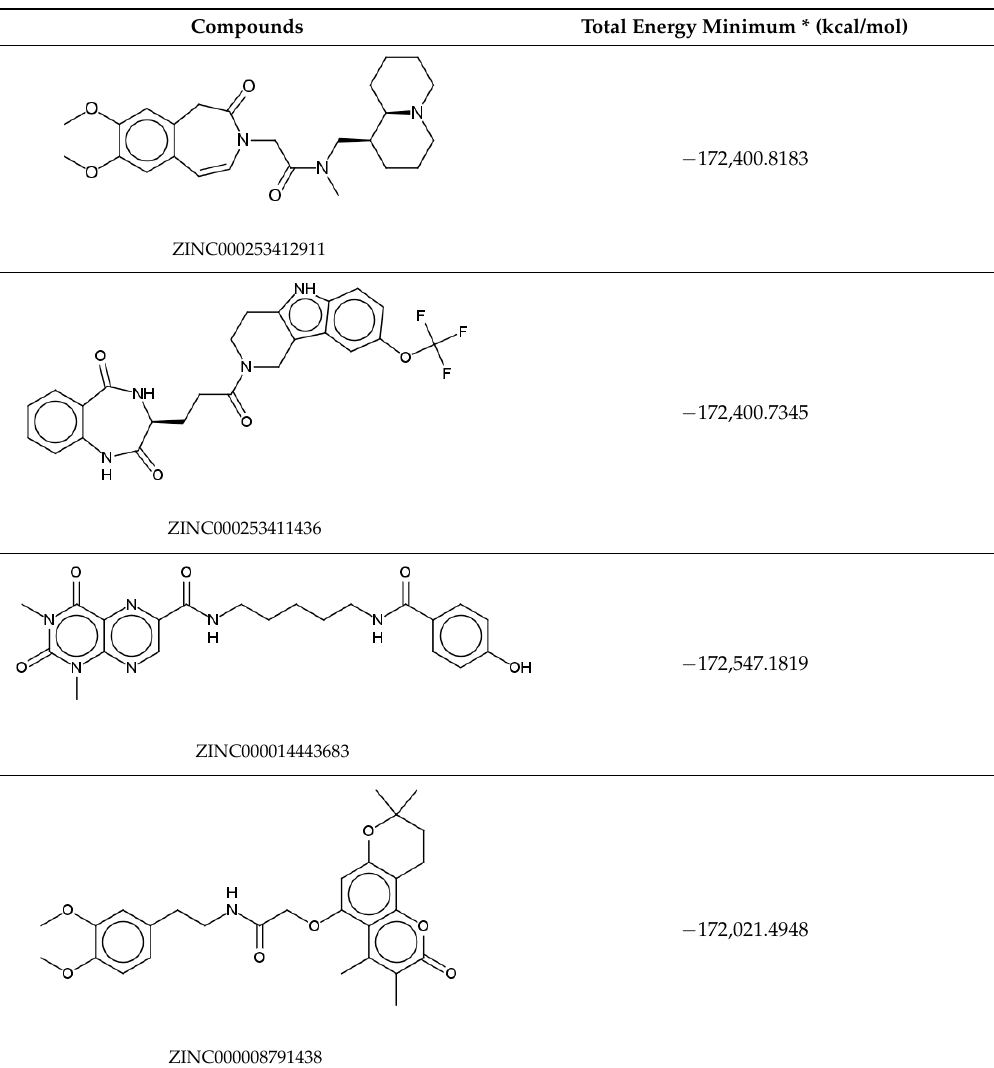
Table 2. Virtual screening hits containing amide bond and their minimum total energy values resulted from short MD simulations as potential acetylcholinesterase inhibitors (AChEIs).